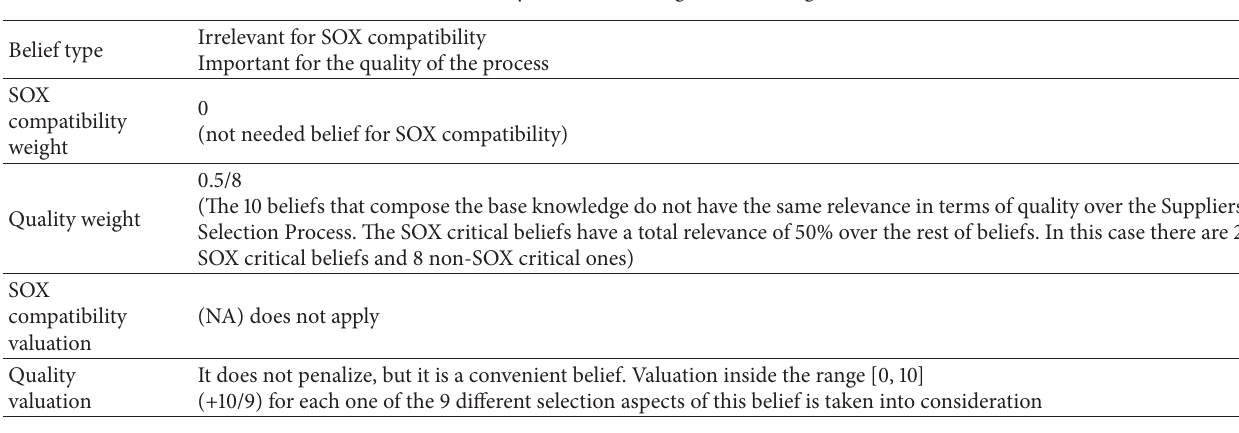
Table 11: Flexibility and Risks Management Scoring Protocol.